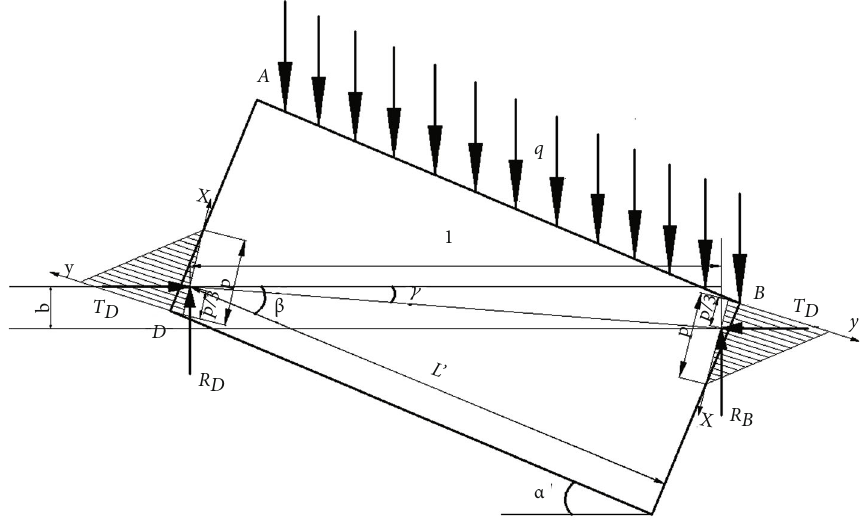
Figure 13: Force analysis and geometric analysis.